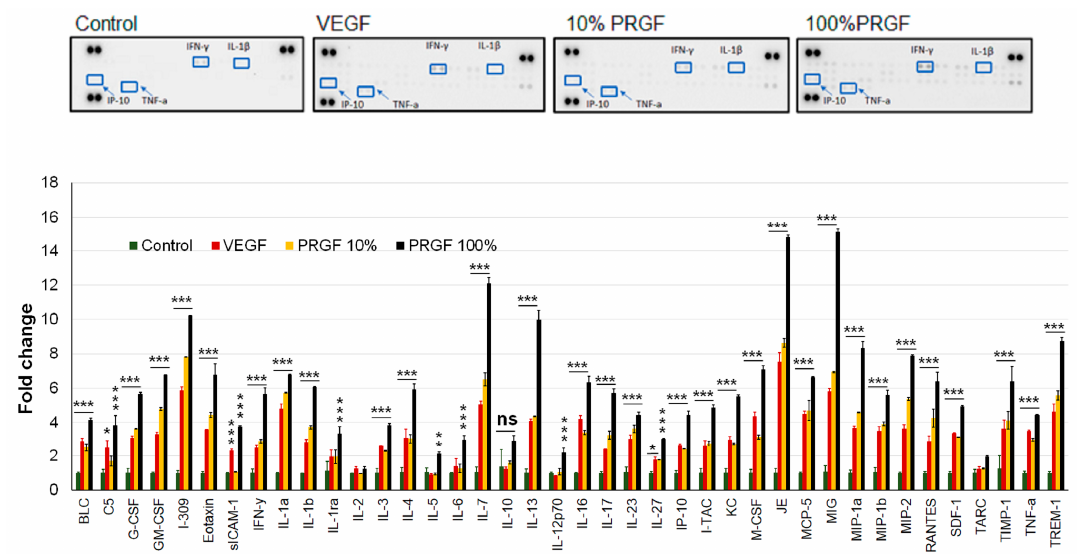
Figure 8. Effect of VEGF (100 pg/mL) and PRGF (10 and 100%) treatments on cytokines levels in